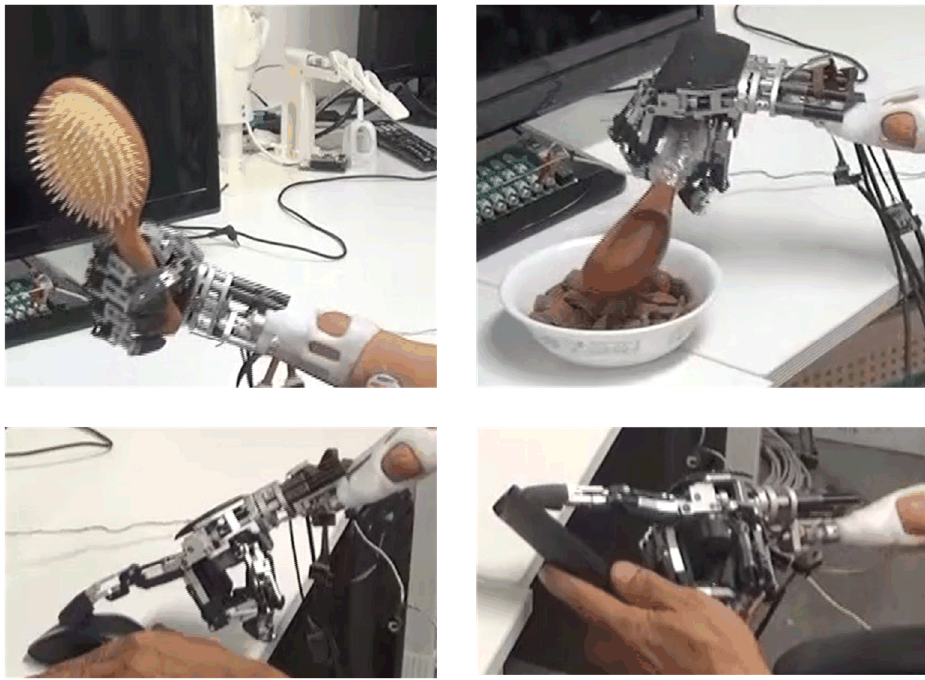
Figure 9. Performance of diverse tasks by a patient: grasping a hair brush and spoon (upper) and pushing computer mouse and remote control buttons (lower).